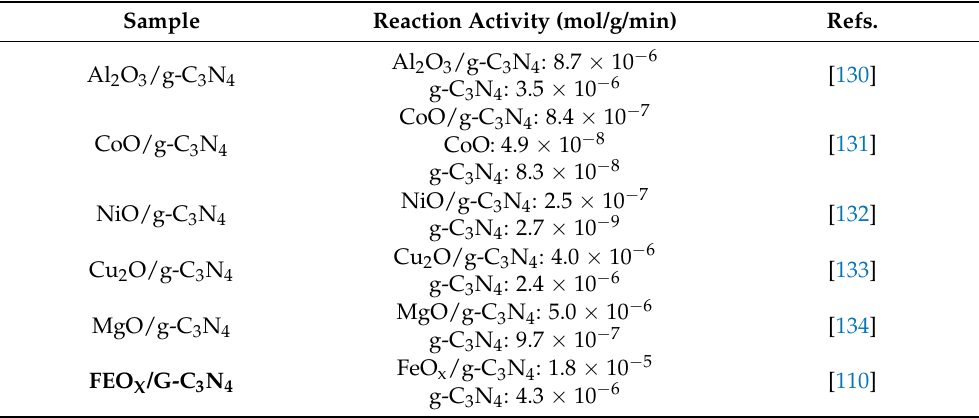
Table 3. Summary of recent advances in photocatalytic hydrogen evolution using metal oxide/g- C 3 N 4